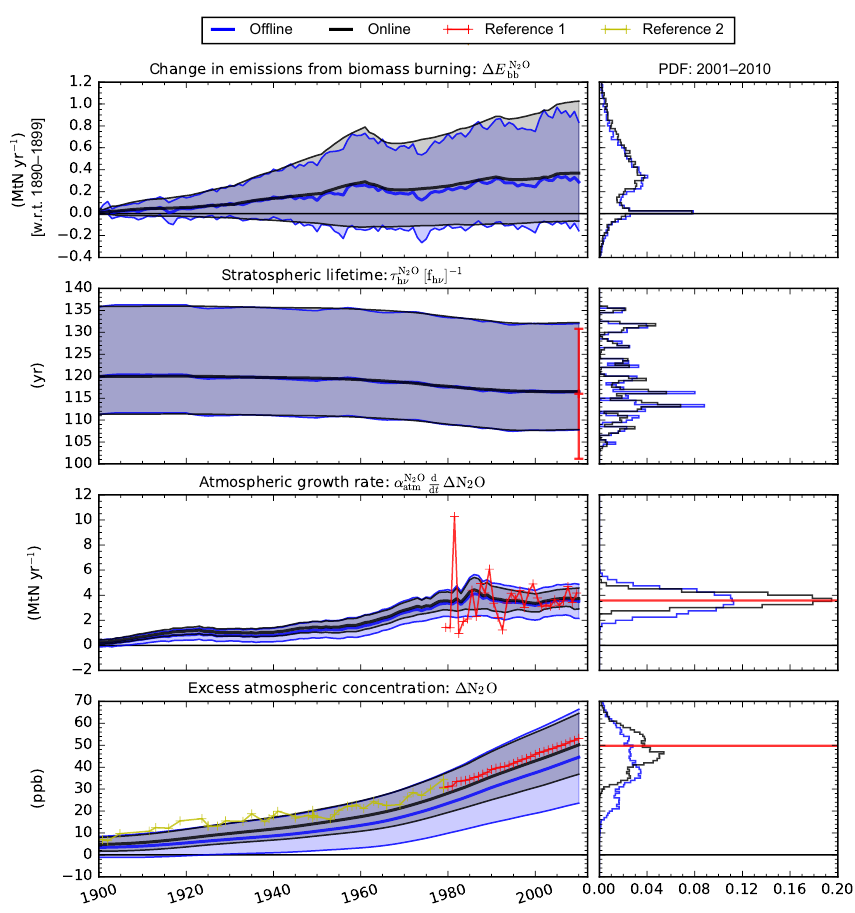
Figure 7. Results of our simulations with OSCAR, for nitrous oxide, with the same format as for carbon dioxide. References are Prather et al. (2015) for the lifetime and 90% uncertainty range (calculated as 1.645 times the 1 σ uncertainty) and AGAGE (Prinn et al., 2013) for the atmospheric growth rate and concentration. Reference 2 denotes Law Dome ice cores (MacFarling Meure et al.,